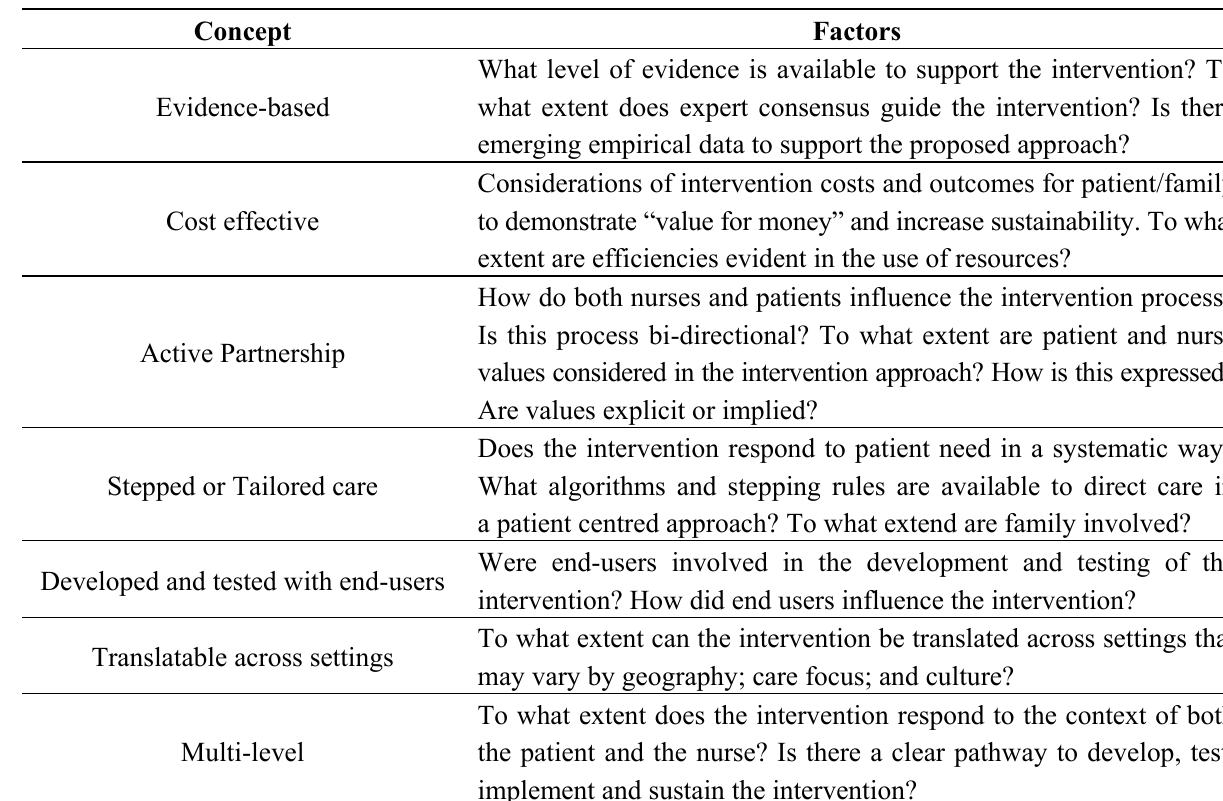
Table 1. Factors to consider when designing PPM-NI based